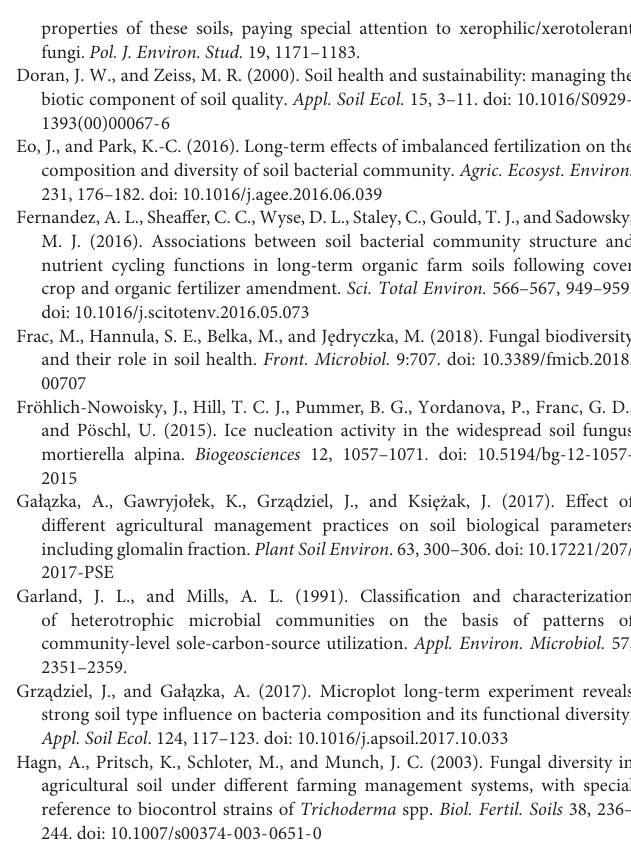
TABLE S1 | Alpha diversity indexes calculated for each of eight soil fungal community. TABLE S2 | Species hypothesis DOI’s. TABLE S3 | PCA calculations. TABLE S4 | Biolog FF AWCD. TABLE S5 | Biolog FF AUC. TABLE S6 | ITS classifications